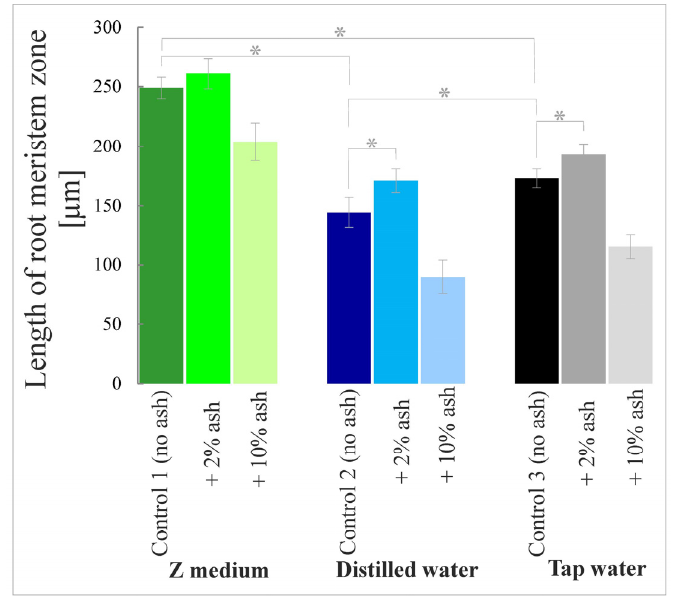
Figure 3. Lengths of the meristematic zones of S. polyrrhiza roots grown in respective media; asterisks show statistically significant differences between particular root lengths at p < 0.05; bars represent standard deviations (average lengths ± SD).